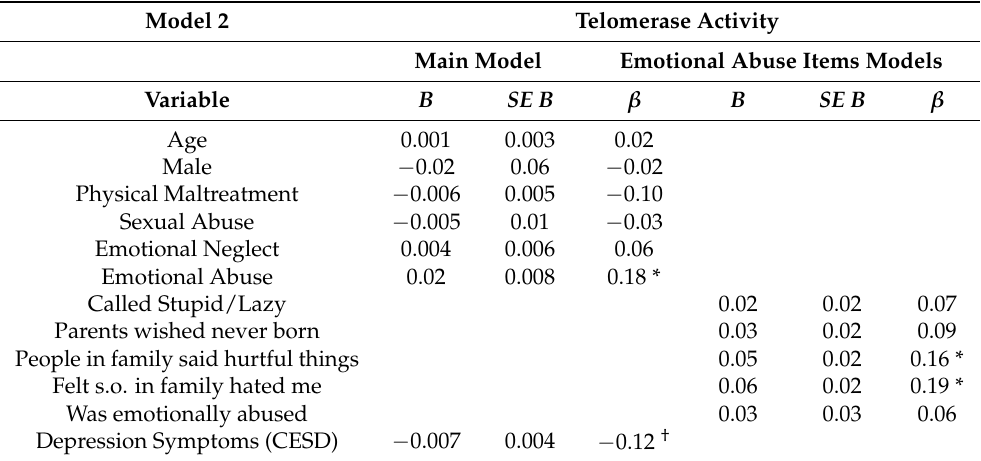
Table 2. Telomerase Activity and Physical, Sexual, and Emotional Maltreatment ( n = 254). Model 2 Telomerase Activity Main Model